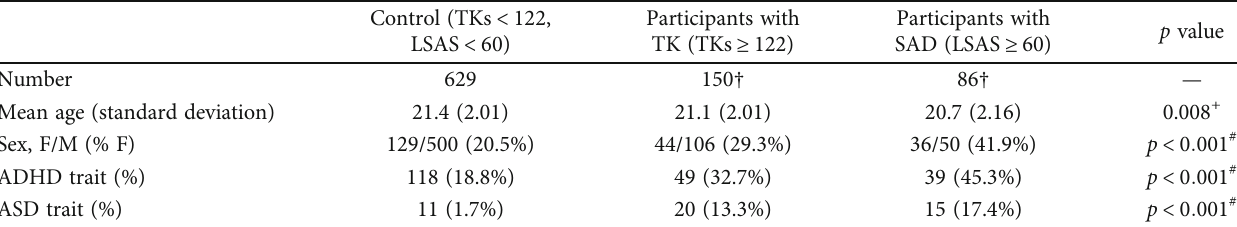
Table 1: Characteristics of participants.